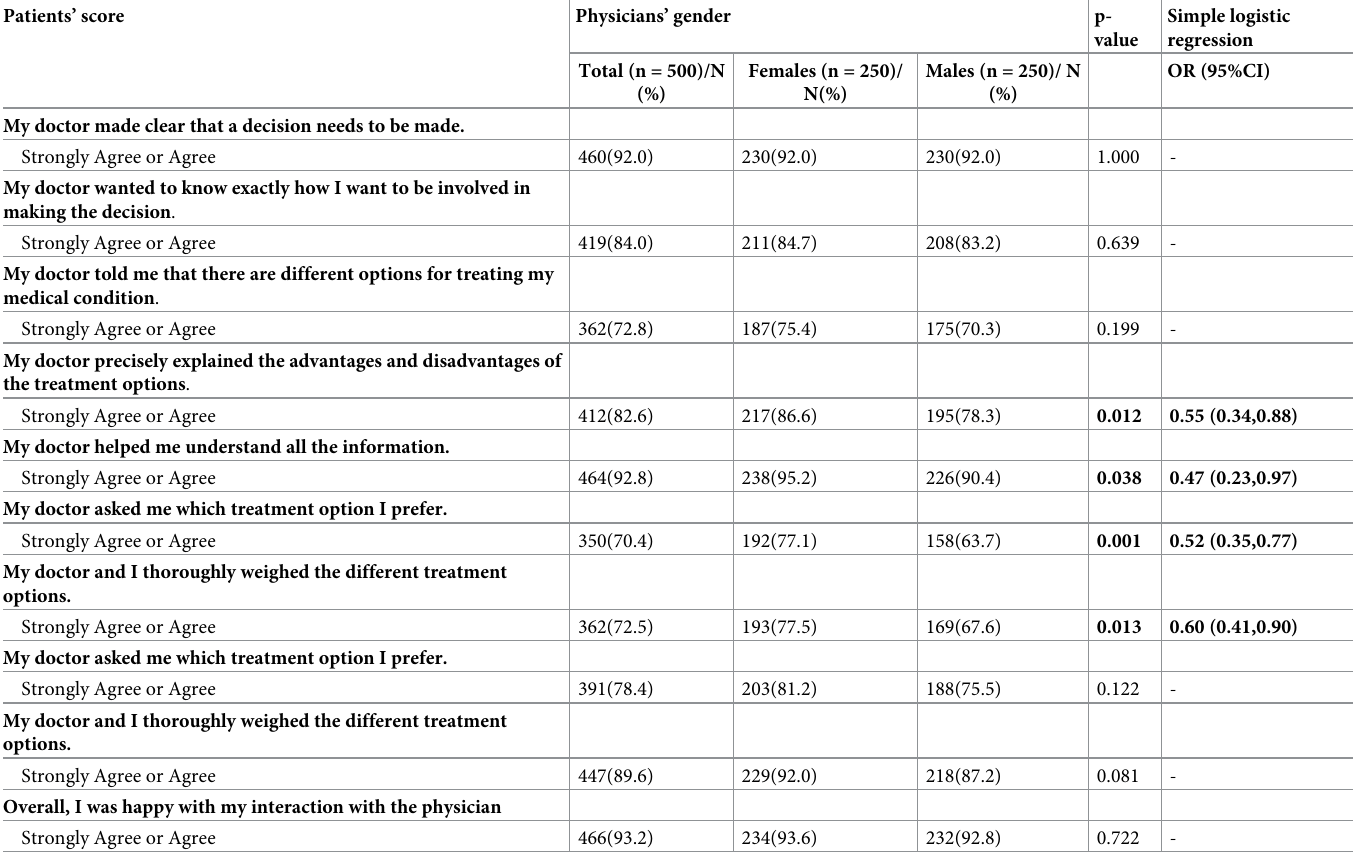
Table 2. Associations between the gender of physicians and the perspective of patients on their opportunity to engage with SDM. Patients’